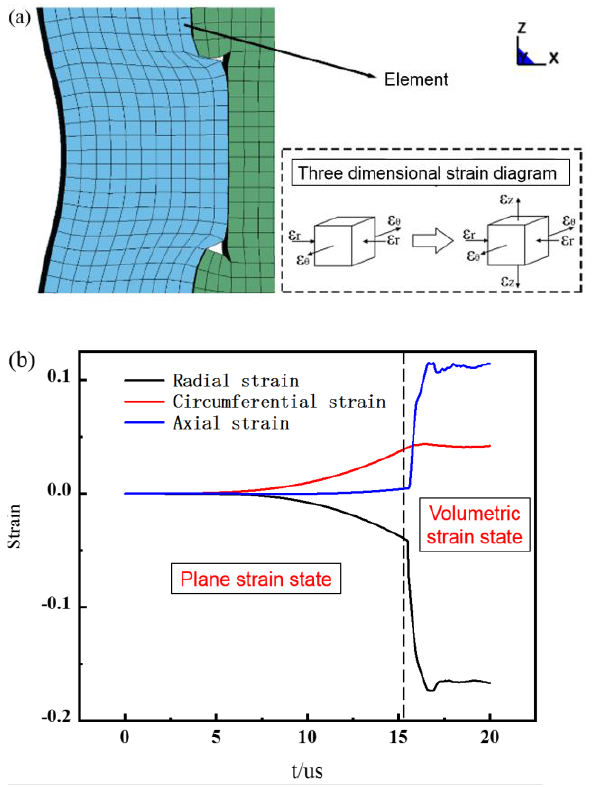
Figure 21. Analysis of the strain state of the deformation zone during the forming process of the pipe joint. ( a ) Element strain state change. ( b ) Element three-dimensional strain change curve.